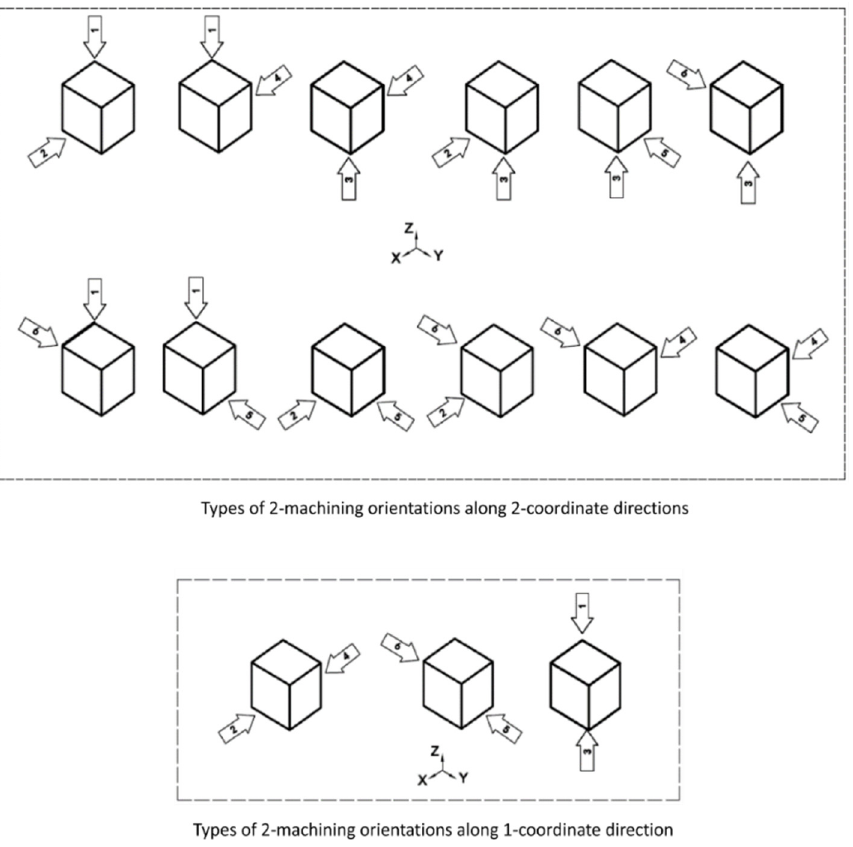
Figure 11. Types of parallel machining orientation combinations when a part is machined in two parallel machining orientations.